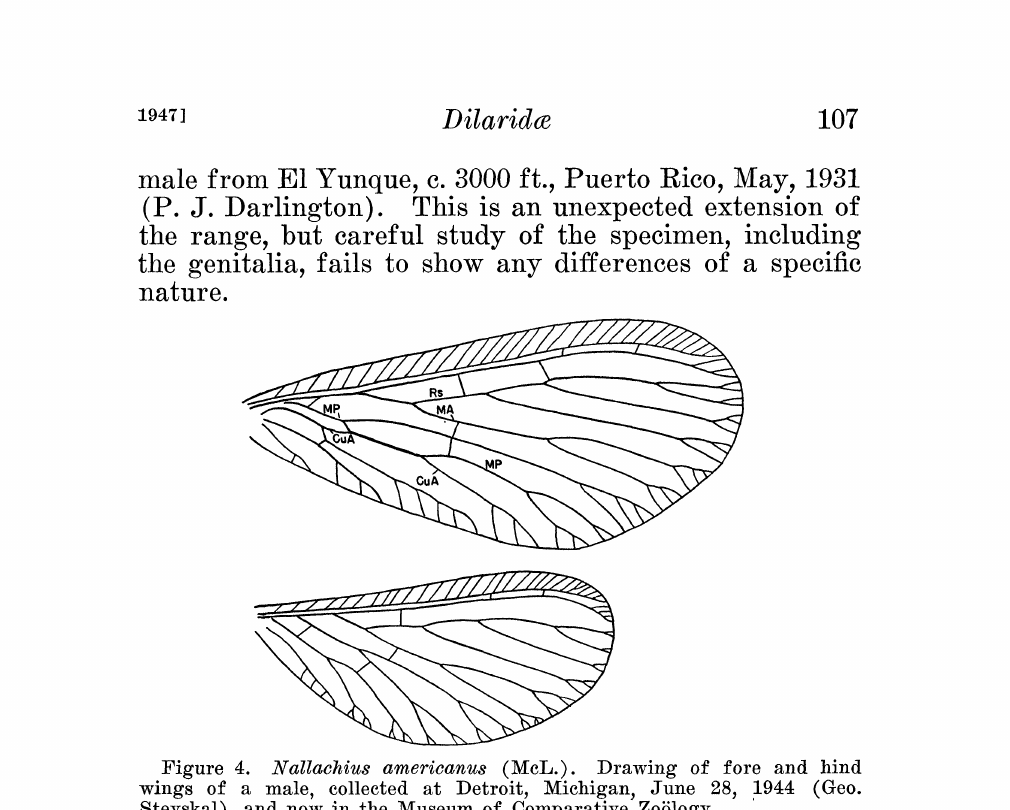
Figure 4. Nalla.chius americanus (McL.). Drawing of fore and hind wings of a male, collected at Detroit, Michigan, June 28, .1944 (Geo. Steyskal), and now in the Museum of Comparative